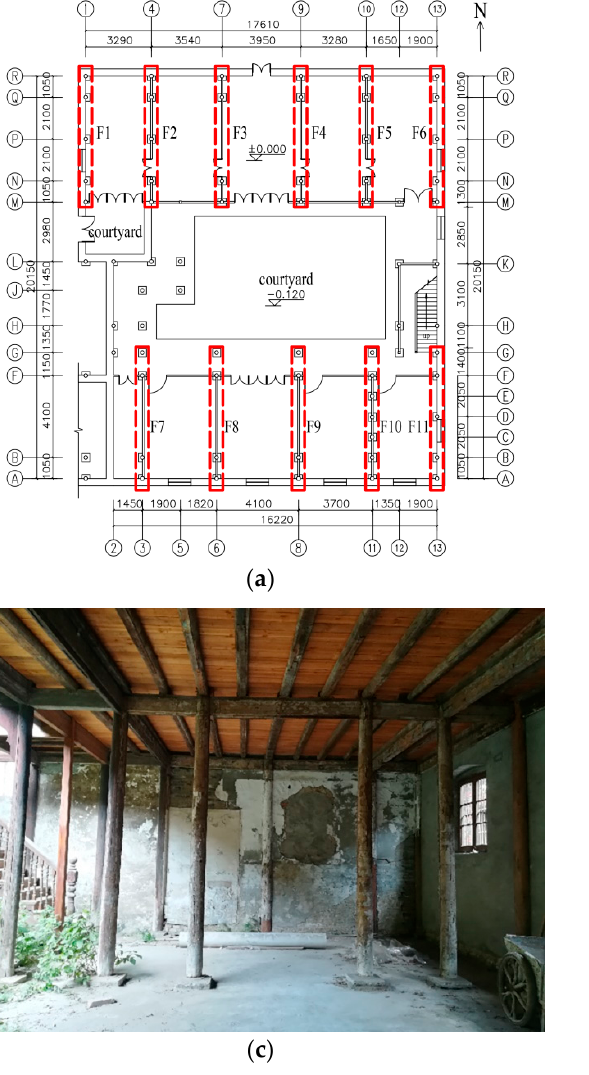
Figure 9. Plans of Fujiu Zhou house (the red dotted boxes show the name of frame); ( a ) the ground floor; ( b ) the first floor; ( c ) the frame structure on the ground floor; ( d ) the frame structure on the first floor.